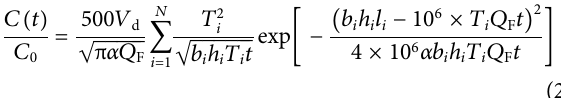
Frontiers in Energy Research |